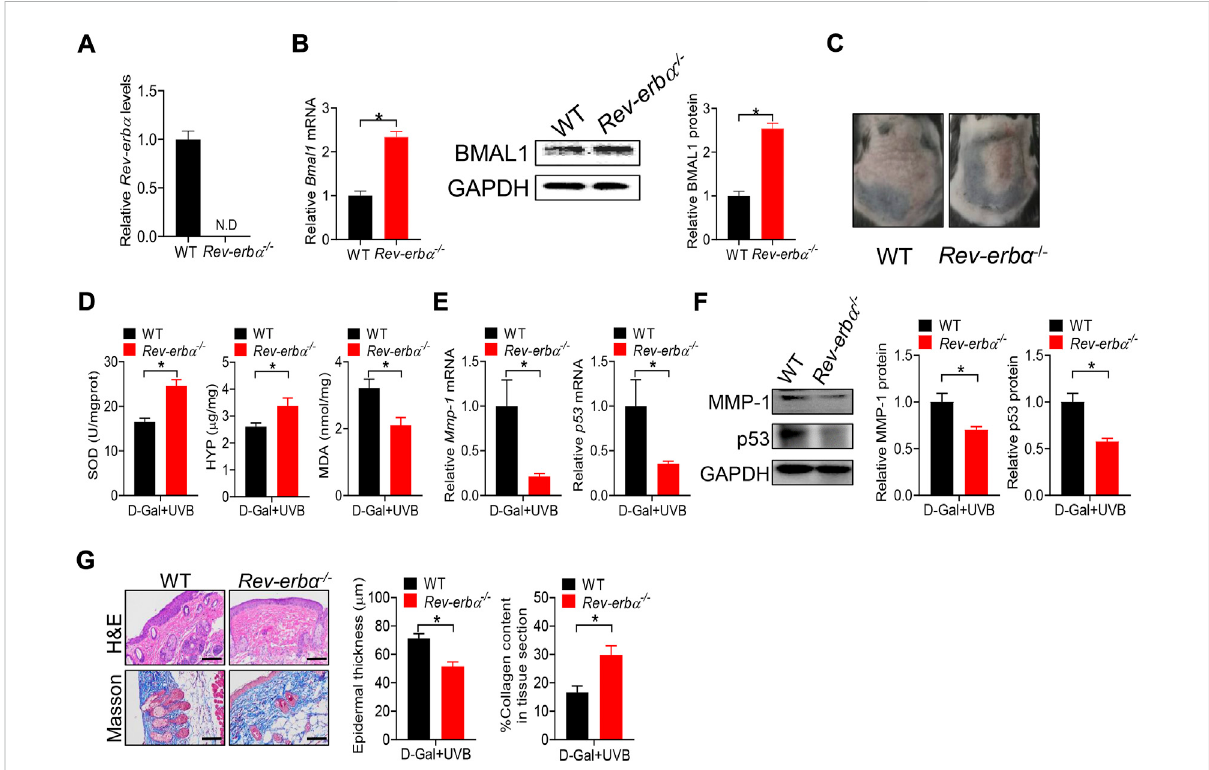
FIGURE 7 Lossof Rev-erb α up-regulatesskinBMAL1andamelioratesskinaginginmice .(A) mRNAexpressionof Rev-erb α inskinderivedfrom Rev-erb α − / − and wild-type (WT) mice. (B) mRNA (left panel) and protein (right panel) expression of BMAL1 in skin derived from Rev-erb α − / − and WT mice. (C) Surface examination of dorsal skin derived from Rev-erb α − / − and WT mice treated with D-gal/UVB. (D) Skin SOD activity and HYP/MDA levels in skin derived from Rev-erb α − / − and WT mice treated with D-gal/UVB. (E) mRNA expression of Mmp-1 and p53 in the skin derived from Rev-erb α − / − andWTmicetreatedwithD-gal/UVB. (F) ProteinexpressionofMMP-1/p53inskinderivedfrom Rev-erb α − / − andWTmicetreatedwithD-gal/UVB. (G) H&E and Masson staining showing epidermal thickness and collagen content in skin derived from Rev-erb α − / − and WT mice treated with D-gal/UVB. In panels A – B, data are mean ± SD ( n = 3). In panels C – G, data are mean ± SD ( n = 7). * p < 0.05 ( t